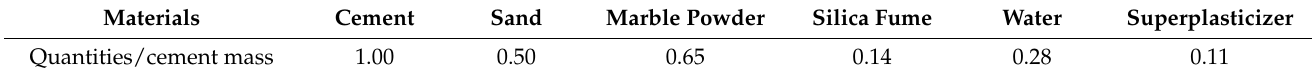
Table 3. Mortar mixture proportion for casting of TRM specimens.